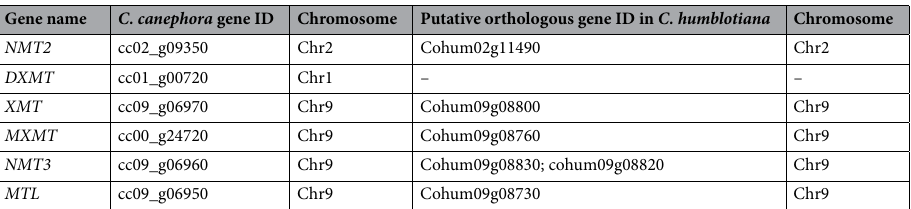
Table 2. List of annotated and classified NMT